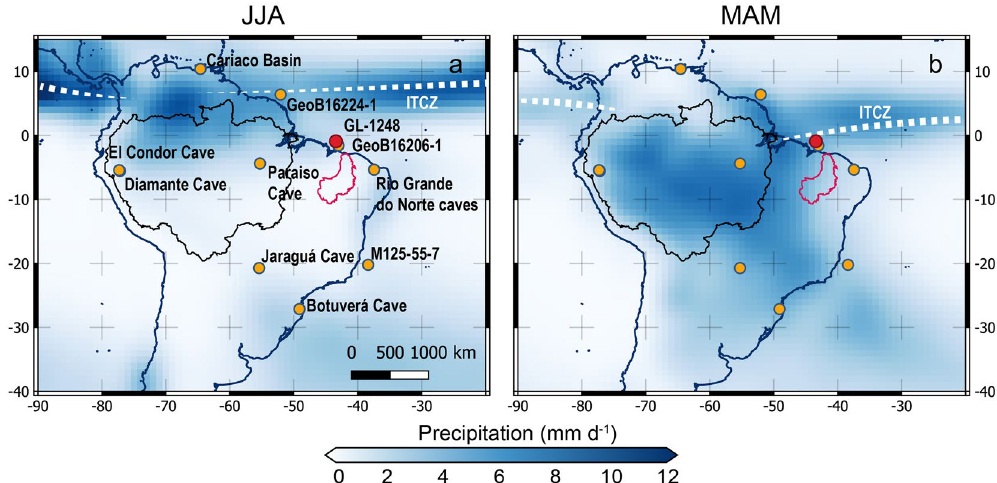
Figure 1. Geographic region of interest for this study and modern climatological precipitation. ( a ) Location of the hydroclimate records (red and yellow circles) discussed herein and June–August (JJA) average precipitation (color shading) 40 . ( b ) Same as ( a ) but for March–May (MAM) average precipitation. White dashed band in panels ( a ) and ( b ) represents the position of the Intertropical Convergence Zone (ITCZ) during JJA and MAM, respectively. Red and black area in panels ( a ) and ( b ) represent the location of the Parnaíba River drainage basin and Amazon Basin, respectively. The location of marine sediment core GL-1248 (this study) is marked with a red circle. The yellow circles mark the location of the flowing hydroclimate records: marine sediment